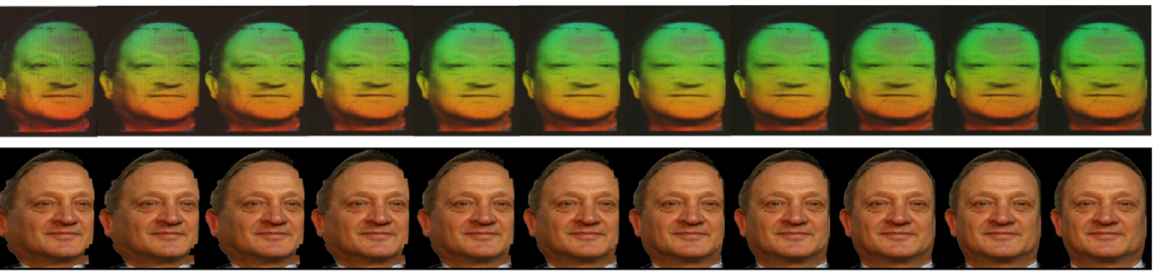
Figure 11. Measurement of the parallax of the hologram-reconstructed image by porting it out into the measurement space; the tips of the needles are highlighted in red.